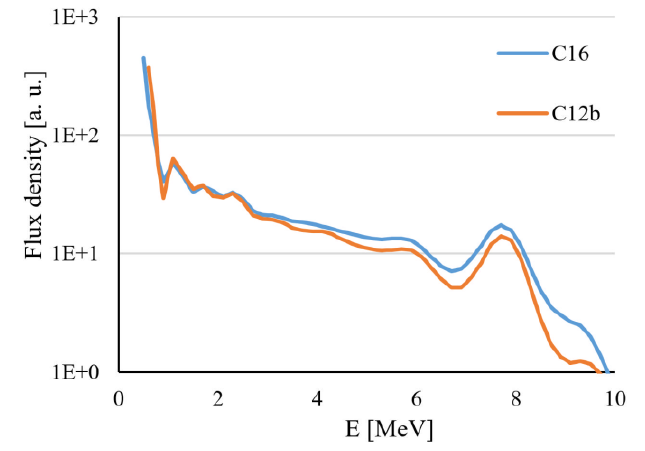
Fig. 9 Comparison of measured gamma spectrum above water level for two different core configurations